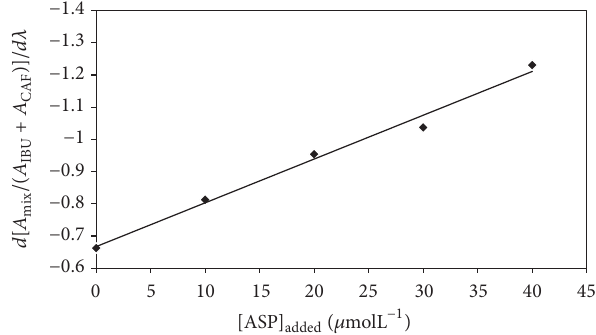
F5:Standardadditionplotforthederivativeofdoubledivisor- ratio spectra for a mixture of ASP